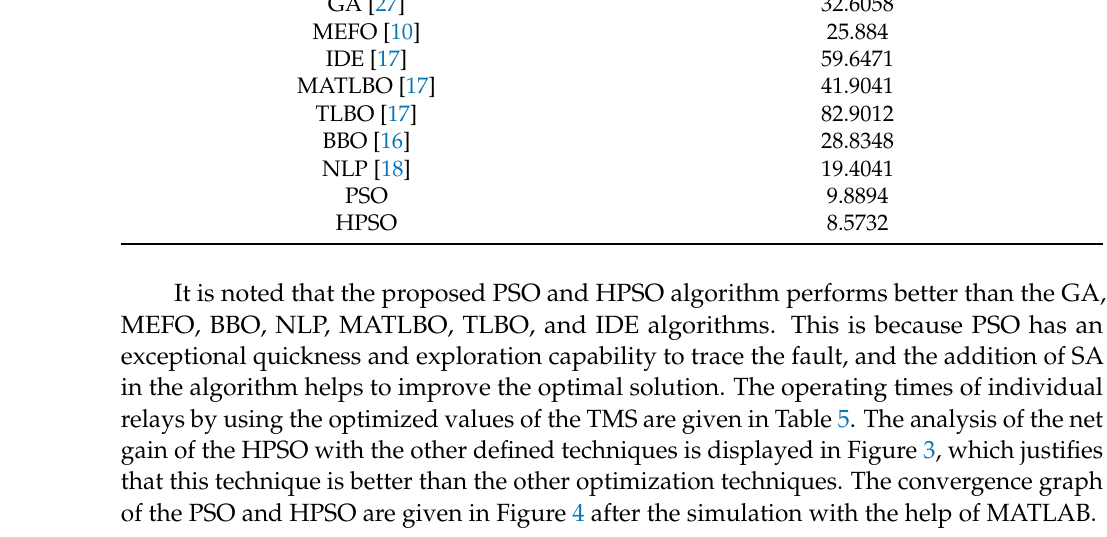
Table 5. Operating time of individual relays for the optimized values of the TMS.